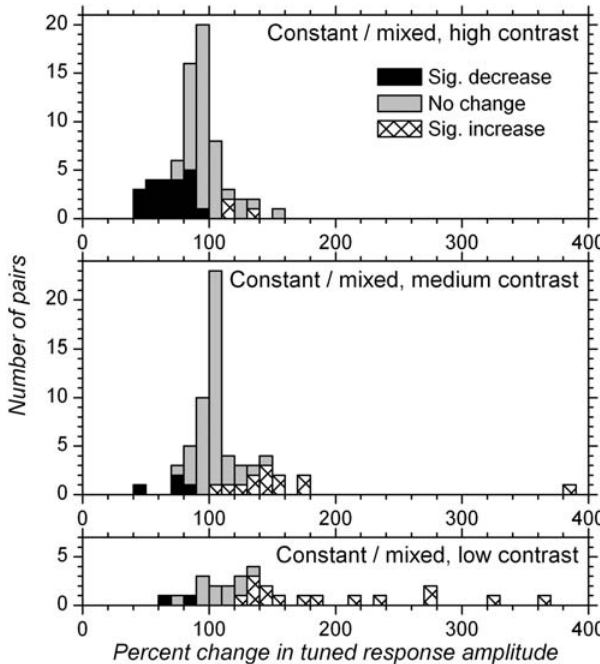
Figure 5. Comparison of tuned response amplitude with the same contrast in mixed and in constant contrast blocks. The distribution histograms show response amplitude obtained, for a given contrast, in constant contrast blocks as a percentage of that obtained in the mixed contrasts block. Upper histogram shows distribution for high contrast, middle histogram for medium contrast, and lower histogram for low contrast. Bar filling refers to significance of changes at the single cell level (t-test): black indicates significant decrease of response amplitude after matched adaptation compared to unmatched adapta- tion, gray indicates lack of significant changes (p . 0.05), and hatched indicates significant increase. 100% on x-axis corresponds to no change in response amplitude. Relative to 100%, the distribution for high contrast is shifted to the left, indicating that response amplitude was larger for high contrast when neurons were adapted to a mixture of contrasts, compared to when neurons were adapted to the high contrast. On the contrary, the distribution of percent change for low contrast stimuli appears shifted to the right: response amplitude was lower on average for low contrast stimuli when neurons were adapted to mixed contrasts compared to when neurons were adapted to the low contrast. The distribution for medium contrast is more centered, although responses to medium contrast were slightly stronger, on average, after adaptation to medium contrast compared to adaptation to mixed contrasts.